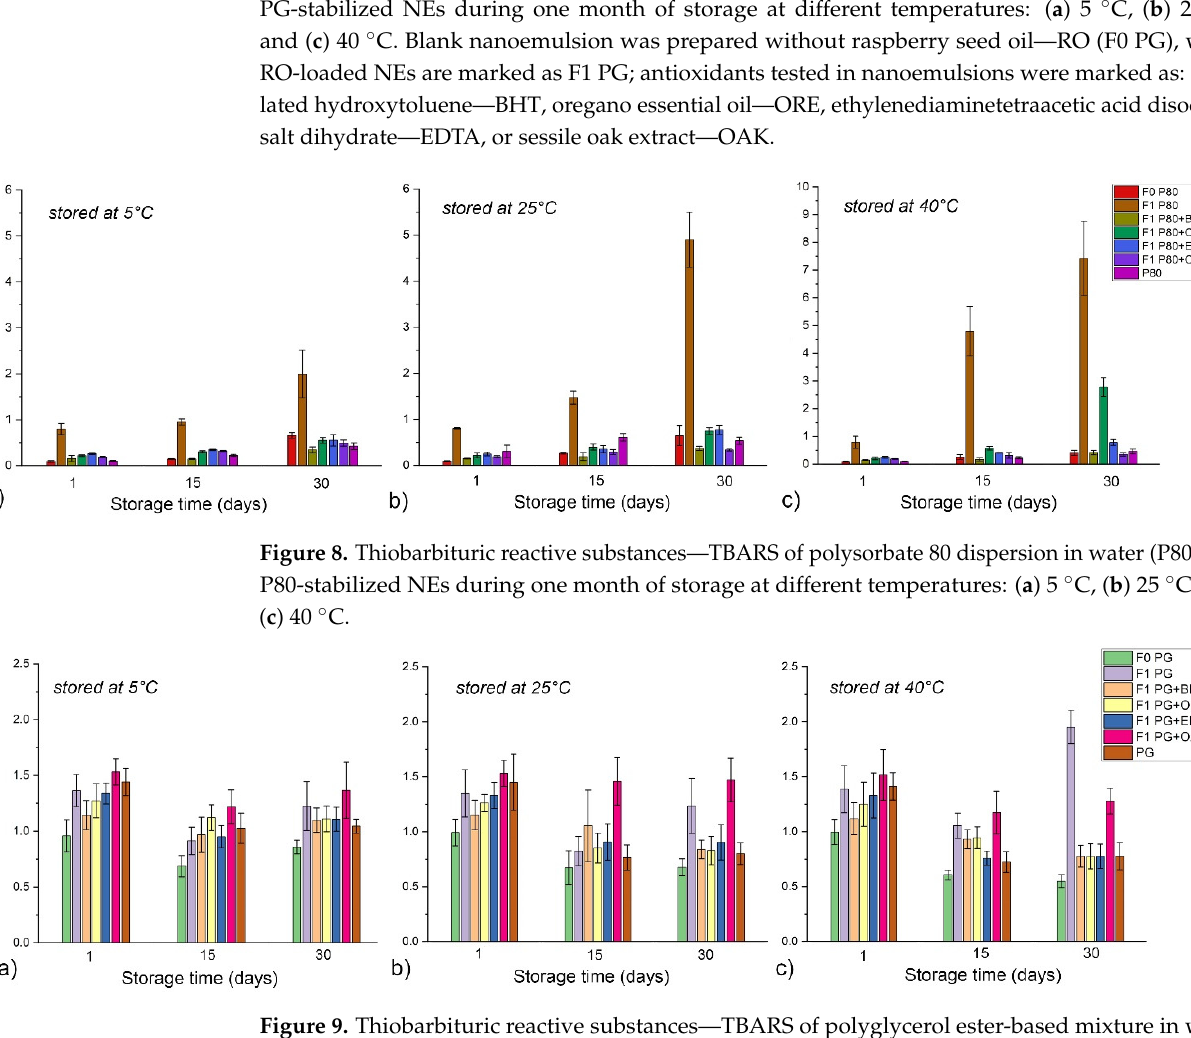
Figure 9. Thiobarbituric reactive substances—TBARS of polyglycerol ester-based mixture in water (PG) and PG-stabilized NEs during one month of storage at different temperatures: ( a ) 5 °C, ( b ) 25 °C, and ( c ) 40 °C.